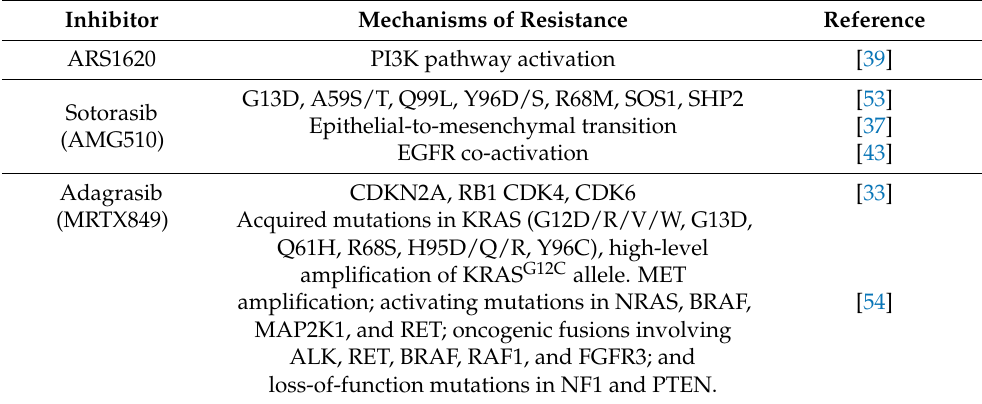
Table 2. Mechanisms of acquired resistance to KRAS G12C